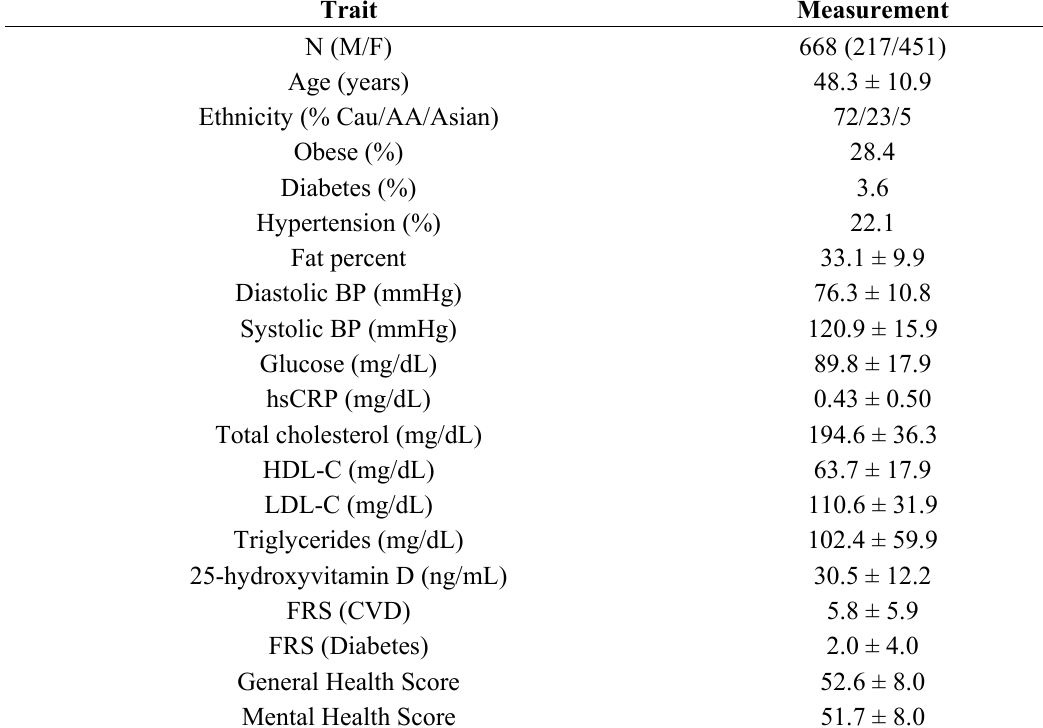
Appendix Table A1. Demographic and clinical characteristics of CHDWB cohort at first visit.